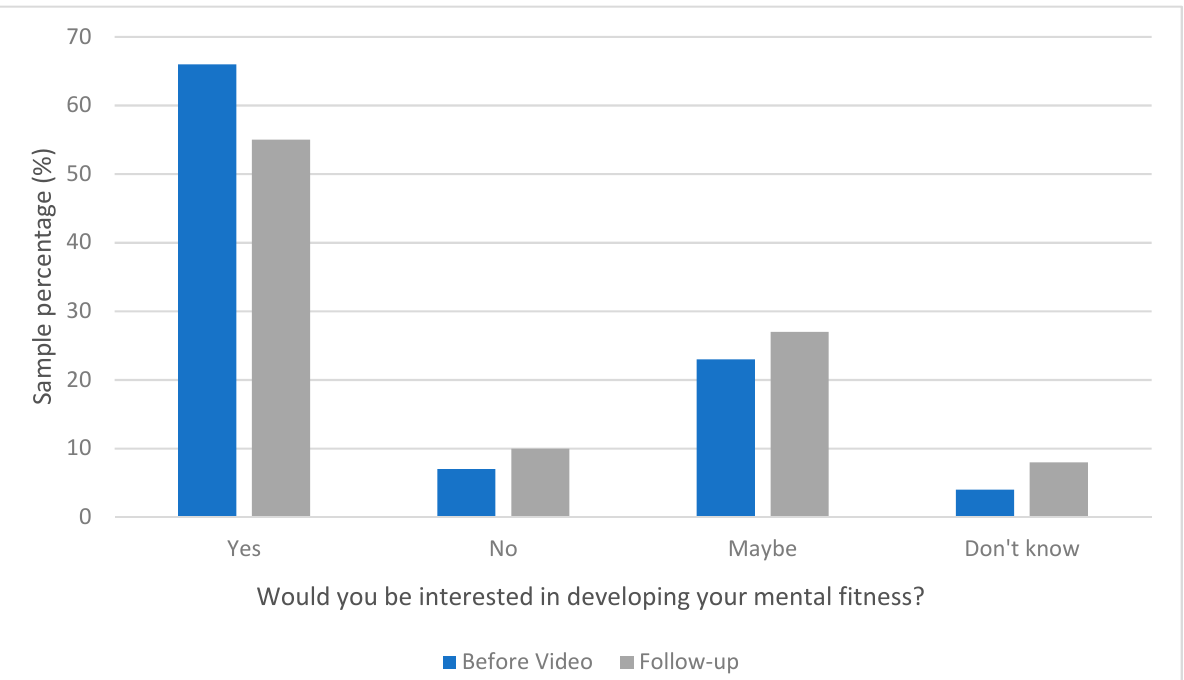
Figure 2. Beneficiaries interest in developing their mental fitness. Findings indicated a positive response to the HeadFIT briefing video, with benefi- ciaries suggesting that the HeadFIT initiative was relevant to them, provided useful infor- mation and increased their understanding of mental fitness (Table 3).